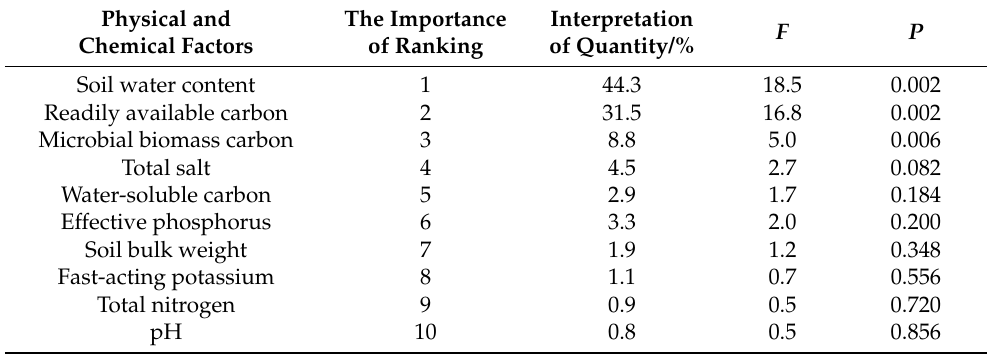
Table 1. Significance ranking and significance test results for the explanation of physical and chemical environmental